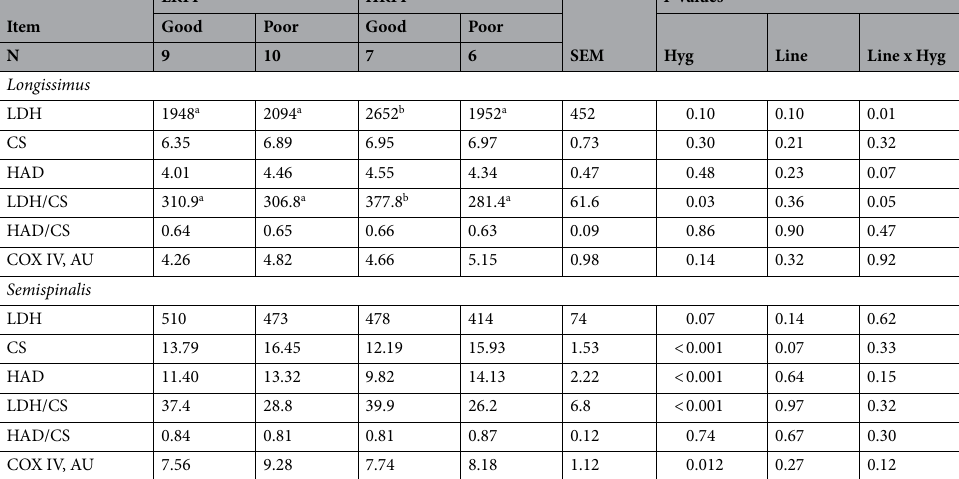
Table 3. Activities of lactate dehydrogenase (LDH), citrate synthase (CS), and β-hydroxy-acyl-CoA dehydrogenase (HAD) and levels of COX IV in longissimus and semispinalis muscles of pigs divergently selected for low (LRFI) or high (HRFI) residual feed intake and raised in good or poor hygiene conditions (Hyg). Enzyme activities were expressed as micromoles of substrate degraded per minute per gram of fresh muscle. COX IV was determined by western blot and expressed as arbitrary units (AU). Values are LS means. a,b Within a row, means without a common superscript differ (P <